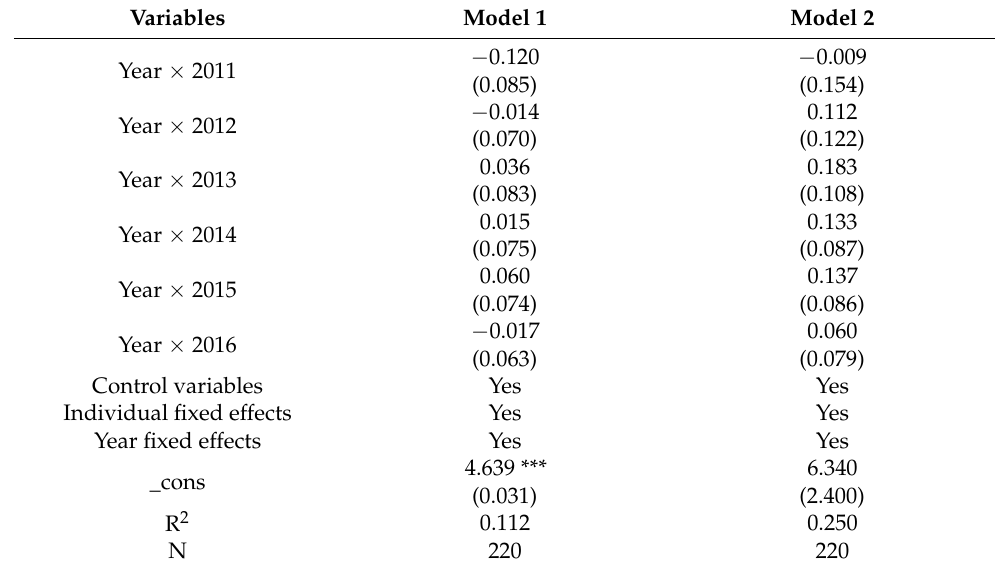
Table 8. Results of the parallel trend test.